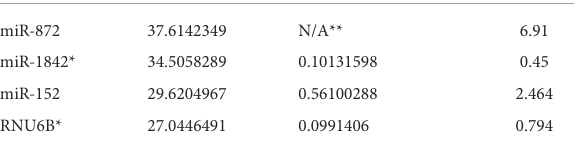
TABLE 2 Median quantification cycle (CQ), standard error calculation, and stability values of candidate reference genes calculated using the NormFinder algorithm.